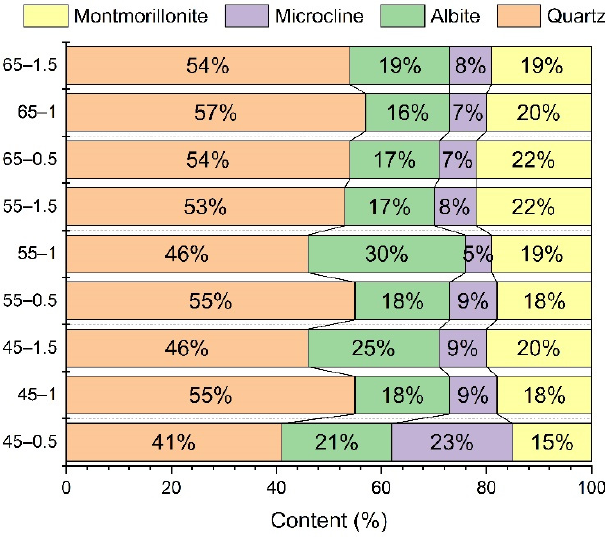
Figure 3. Mineral composition under different temperature and flow rate conditions.